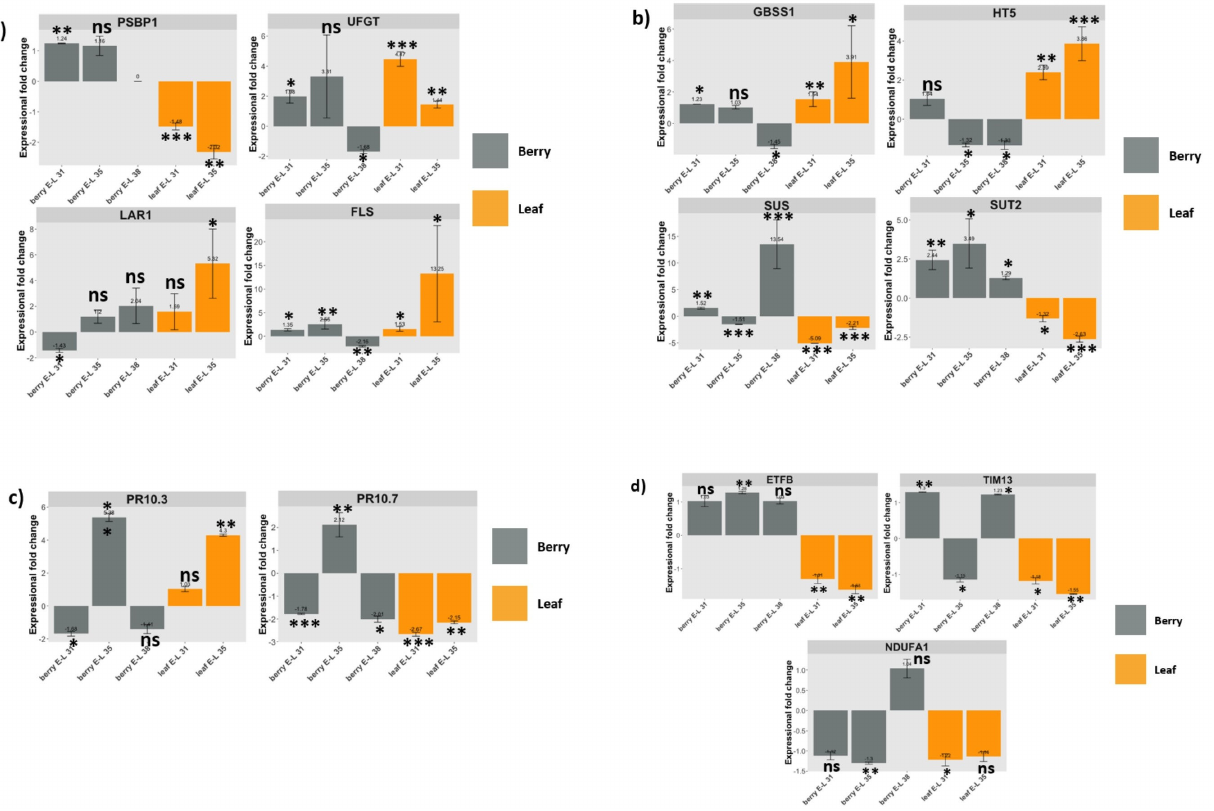
Figure 3. Expression patters of 12 genes of interest (GOIs) measured by RT-qPCR. Fold change of each GOI was compared between GLRaV-3-infected samples and control samples in leaf (orange bars) at E-L 31 and E-L 35 stage and in berry (grey bars) at E-L 31, 35, and 38 stages. ( a ): Fold change of genes representing photosynthesis (PSBP) and flavonoid biosynthesis (UFGT, LAR1, and FLS); ( b ):